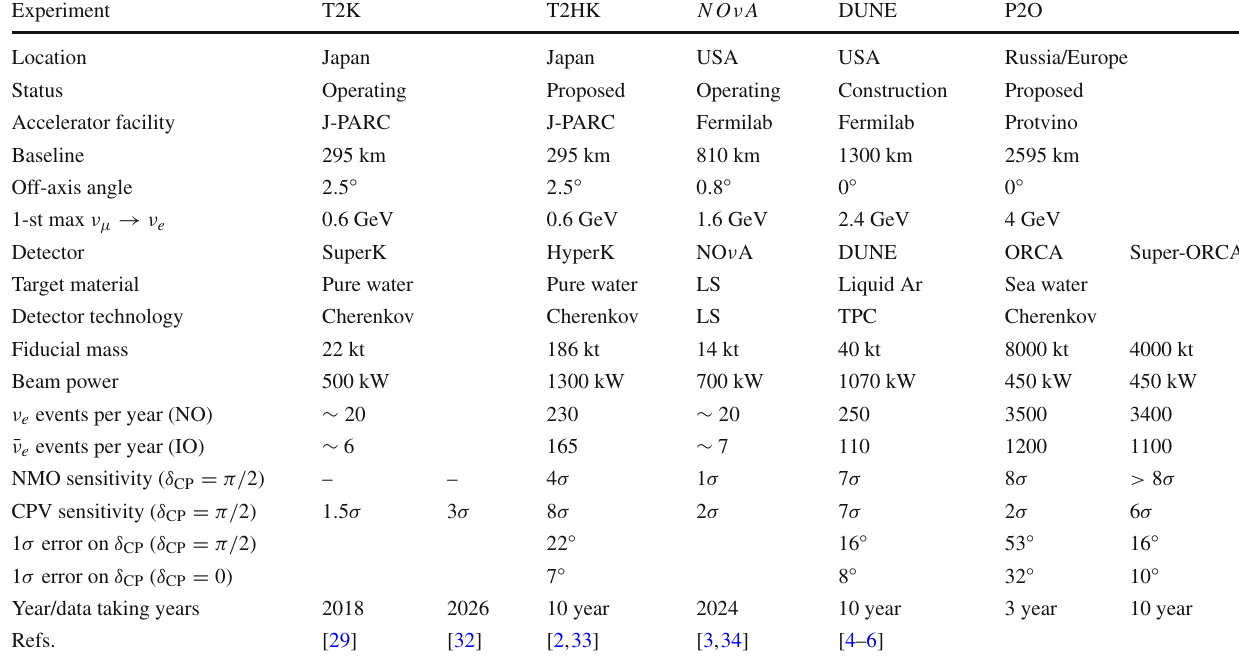
Table2 Sensitivityofpresentandfuturelong-baselineacceleratorneu- trino experiments to neutrino mass ordering (NMO) and leptonic CP violation (CPV). All sensitivities are given for the case of normal mass ordering.Expectednumberof ν e ( ¯ ν e